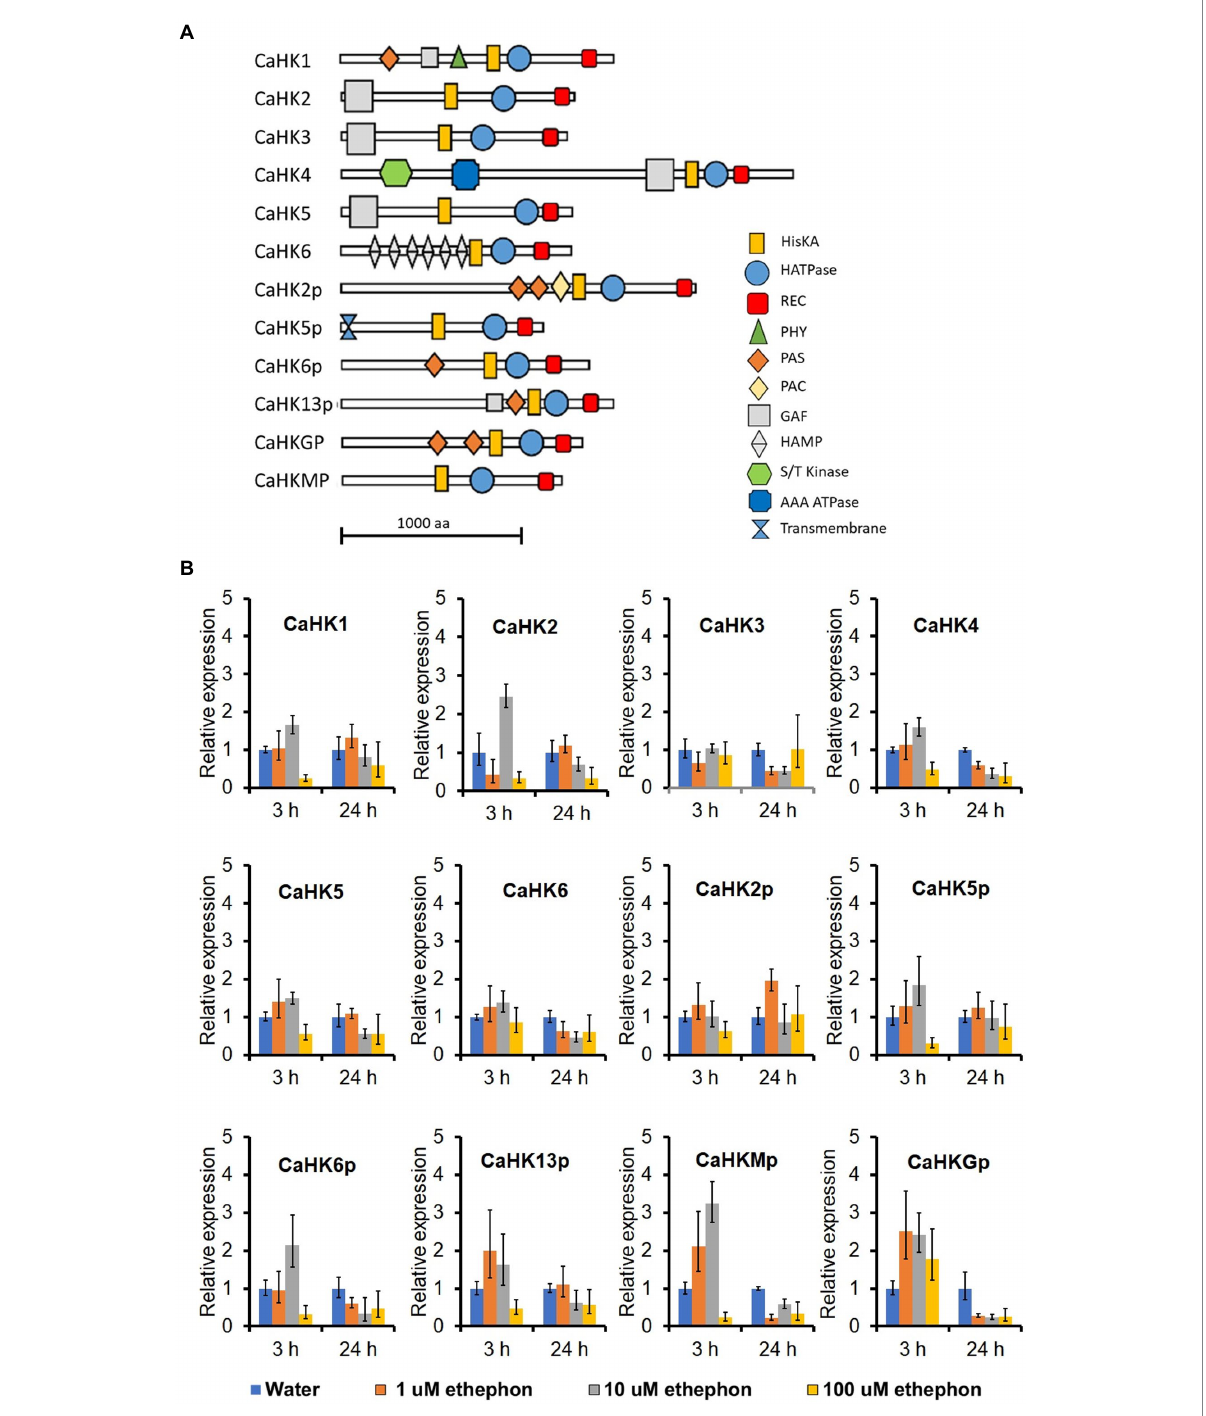
FIGURE 2 The protein structure and functional domain of the 12 histidine kinase (HK) genes of Collototrichum asianum TYC-2 (A) and their relative expression levels at 3 and 24 h under 0, 1, 10 and 100 μ M ethephon treatments (B) . Relative expression was determined using actin gene as internal control and calculated with comparative ΔΔ Ct method by comparing to water treatment at each time